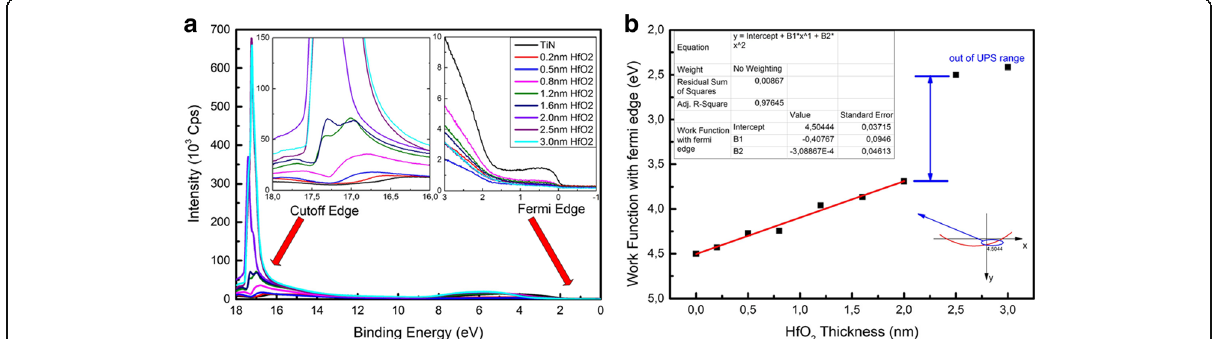
Fig. 5 Extraction of density of oxygen vacancies. a UPS of HfO 2 /TiN structure. The cut-off edge has been normalized to [0, 1]. b Oxygen vacancies fitting result from work functions of